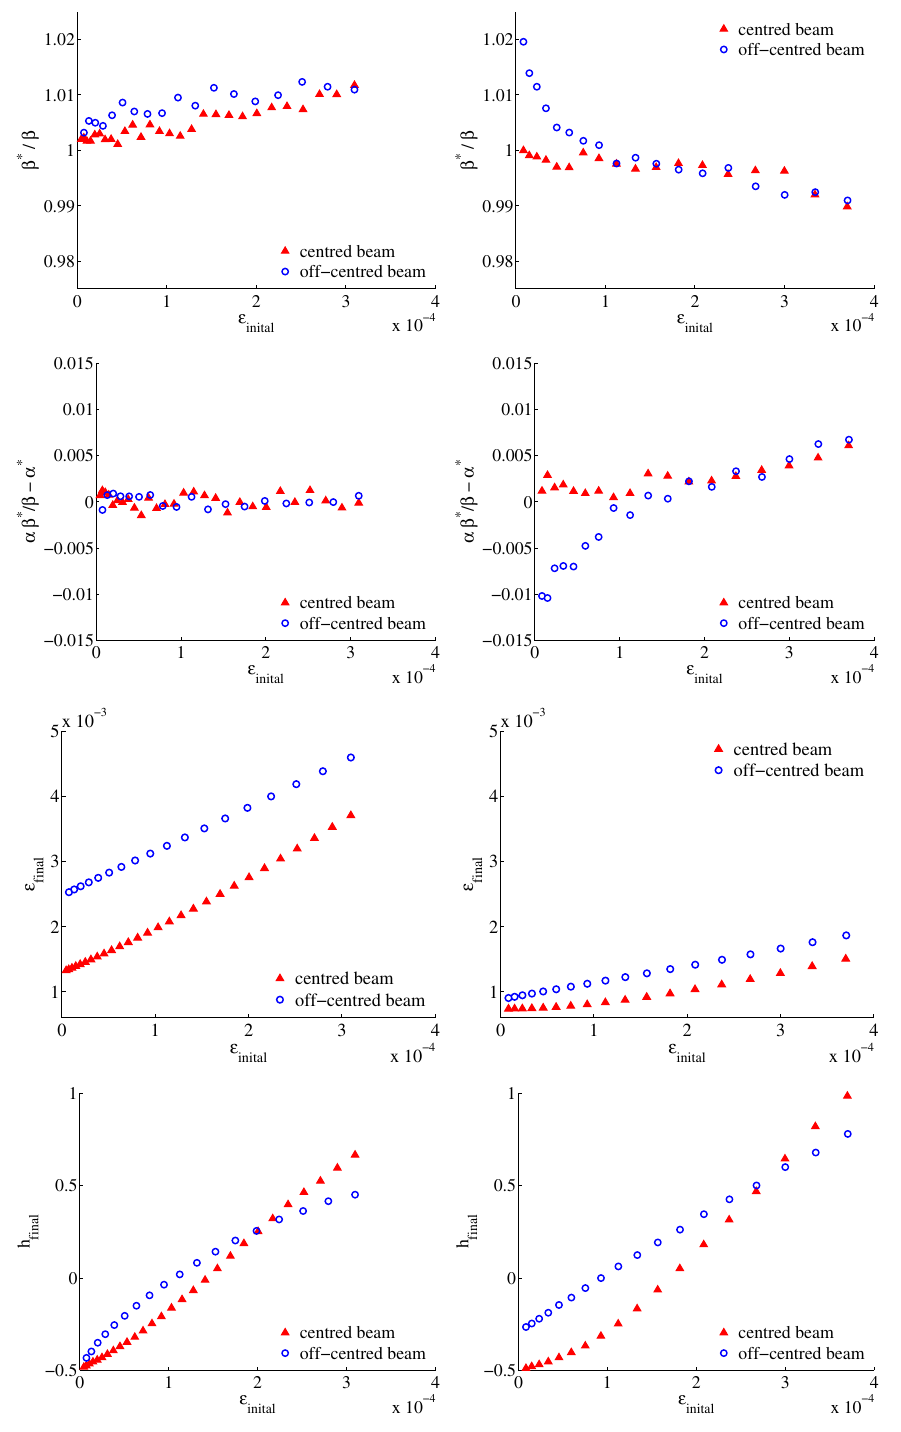
FIG. 7. (Color) Optical mismatch parameters, final emittance, and halo parameter as a function of the initial emittance of the injected beam for the four-turn injection (left column) and for the three-turn injection (right column). The solid triangles correspond to injecting the beam at the center of the rightmost island, while the open circles to injecting the beam displaced from the island’s center. For the four-turn injection (respectively three-turn) the tune values are (cid:5) (cid:3) the number of initial conditions for each injected turn is 2 : 5 (cid:8) 10 4 (respectively 10 6 ), and the displacement of the off-centered beam is (cid:1) ^ X (cid:3) 0 : 0176 (respectively 0 : 0192 ). In both cases, the constant value of p is 1 and (cid:5) n